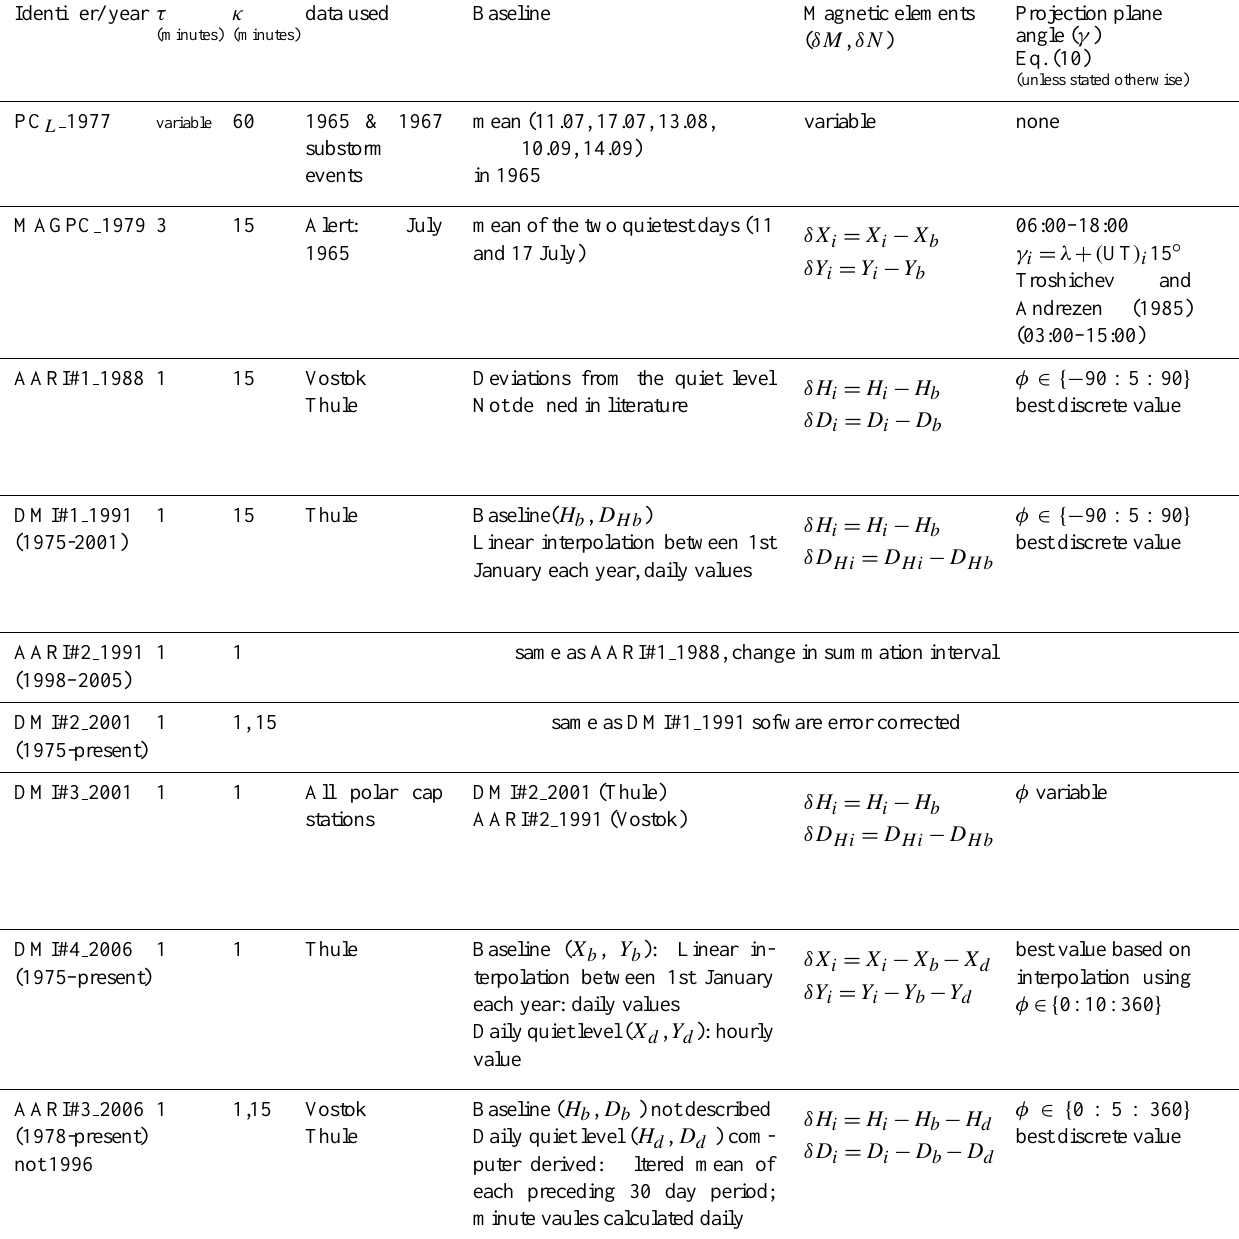
Table 1. Characteristics of the PC